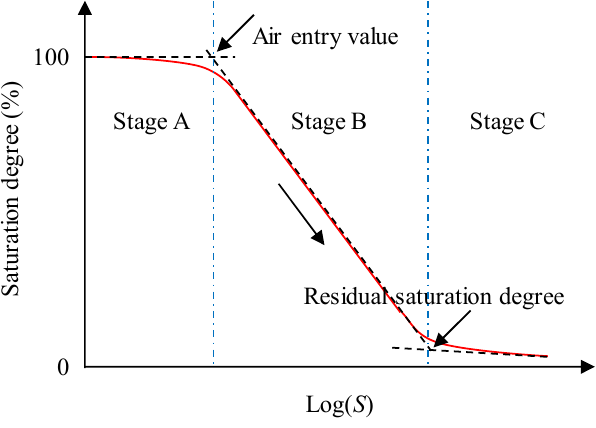
Figure 4. Typical water retention curve.